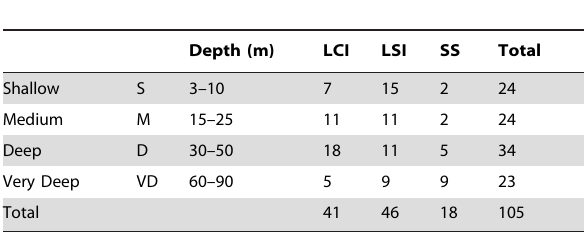
Table 1 . Sample sizes at each depth at each of the three collection